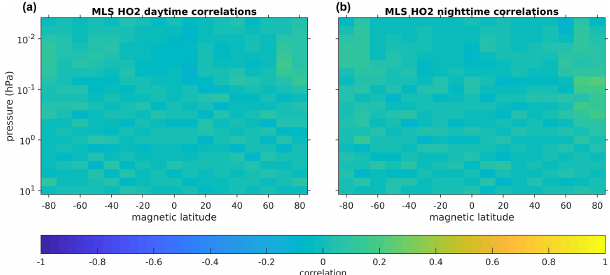
Figure 9. Correlations between SPE indicator and MLS HO 2 con- centrations, showing (a) daytime and (b) nighttime. Due to the low correlations, no threshold values could be